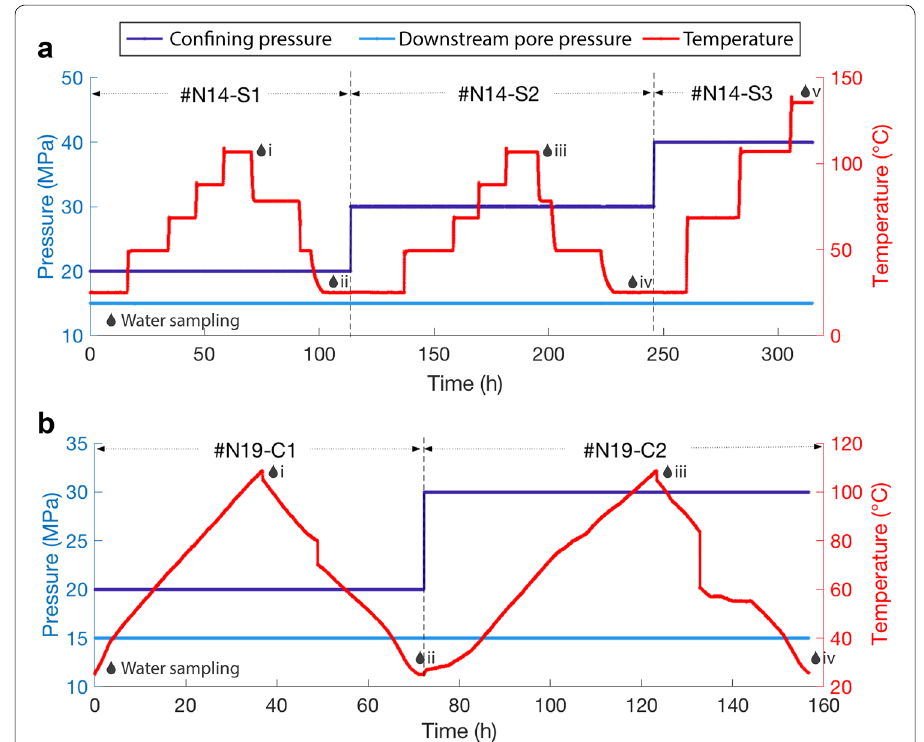
Fig. 6 Stress and temperature paths during the flow‑through experiments. a Step‑wise heating experiments # N14‑S1, # N14‑S2, and # N14‑S3, with Specimen N14, where the cell temperature was adjusted in steps. b Constant‑rate heating experiments # N19‑C1 and # N19‑C2, with Specimen N19, where the cell temperature was increased/decreased continuously. During each experiment, the upstream pore‑fluid pressure was continuously adjusted by Pump 2 (i.e., either increase or decrease), to maintain the prescribed constant injection rate of 0.05 cm 3